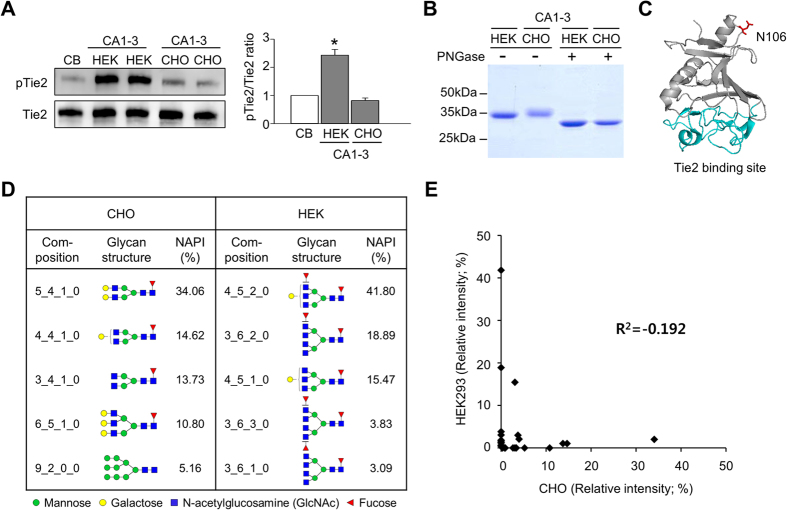
Dimeric CMP-Ang1 has different glycan pattern dependent on cell line.(A) Serum-starved HUVECs were treated with 500 ng/ml of CA1-3 expressed by either HEK293 or CHO cells for 15 min and then the phosphorylation of Tie2 was detected by immunoprecipitation and immunoblotting. The relative ratio of phospho-Tie2 (pTie2) to Tie2 in CB-treated cells is arbitrarily given as 1. Each graph represents the mean ± SD of three experiments. *p < 0.05 versus CB. (B) Analysis of CA1-3 expressed by either HEK293 or CHO cells after treatment of PNGase F to remove N-glycosylation. Reduced protein samples were separated by SDS-PAGE and were stained with Coomassie blue. (C) Crystal structure of FLD in Ang1. The N-glycosylation site, asparagine at 106 residue, is colored in red and the Tie2 binding site is colored in cyan. (D) Analysis of N-glycan of CA1-3 produced from HEK293 and CHO cells. Five glycans with the highest NAPI (normalized absolute peak intensity) values for both CHO and HEK293 cells are shown. Composition represents Hex_HexNAc_Fuc_NeuAc. (E) Correlation of glycans in CA1-3 between HEK293 and CHO cells. R2 value is indicated.